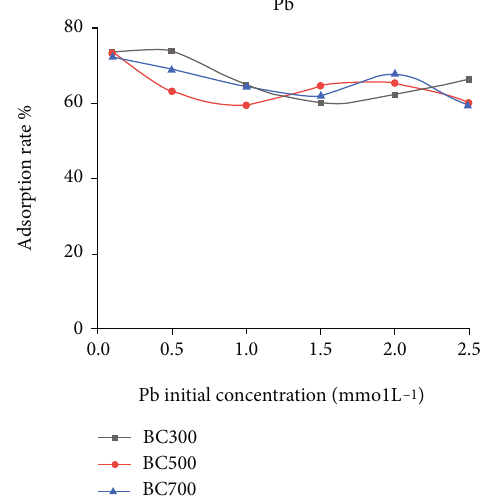
Figure 3: The adsorption rate of Pb 2+ in the mixed working solution of straw in di ff erent concentrations of heavy metal